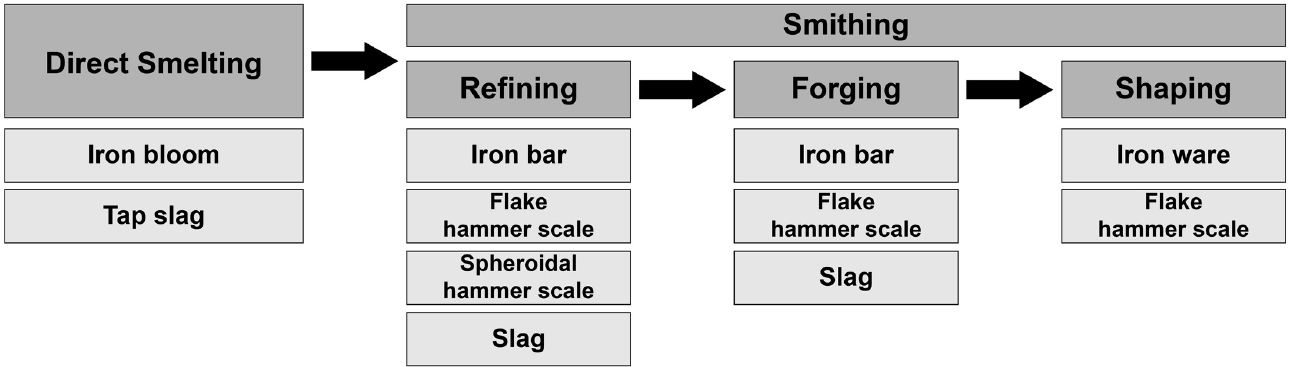
Figure 1. Direct smelting, as used in the iron-making process and iron by-products. In Korea, research into the analysis of the flake hammer scale and spheroidal hammer scale that are generated during reproduction experiments has been ongoing.